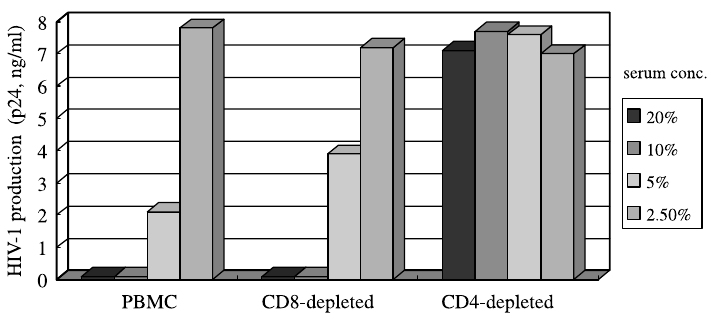
Figure 1. Requirement of human CD4 þ T cells, but not CD8 þ T cells, to generate the R5 HIV-1 suppression factor in the DC-HIV-immune hu-PBL-SCID mice. Together with HIV-DC, PBMC or those depleted of CD8 þ or CD4 þ cells were engrafted into the spleen of four SCID mice per group. After 5 days, mice were boosted with HIV-DC. After 5 days, serum samples from each group were pooled and tested for the R5 HIV-1 suppression activity on activated PBMC. Bars show the means of HIV-1 p24 values in the PBMC culture supernatants on day 5 post infection. HIV-1 proliferation in medium control was